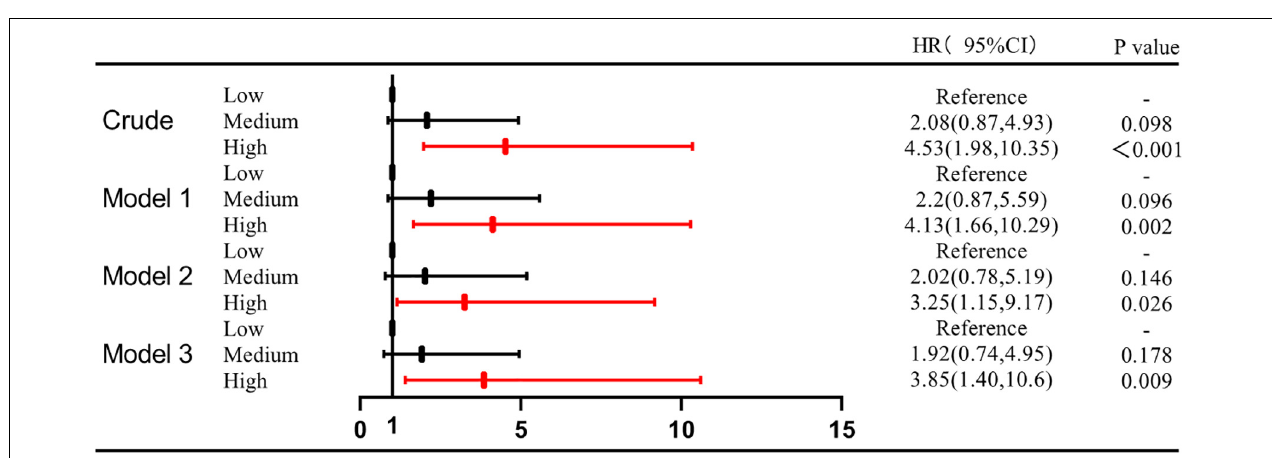
FIGURE 3 | Hazard ratio for MACEs associated with plasma MPO levels in different